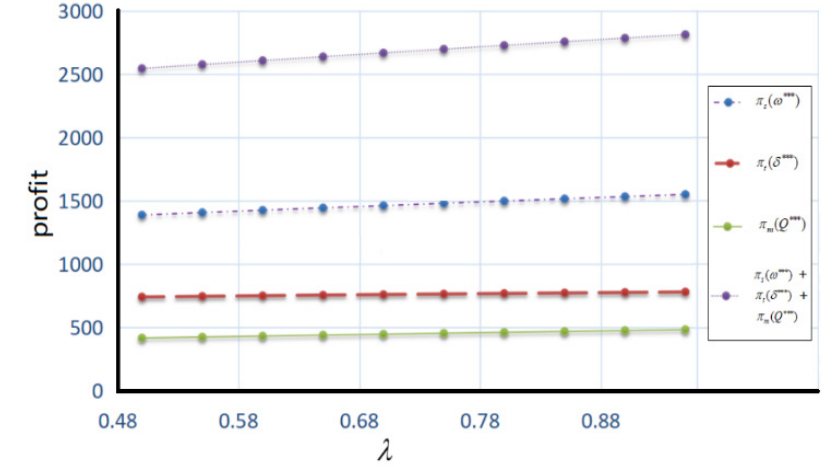
Figure 4. Effects of λ on profits.